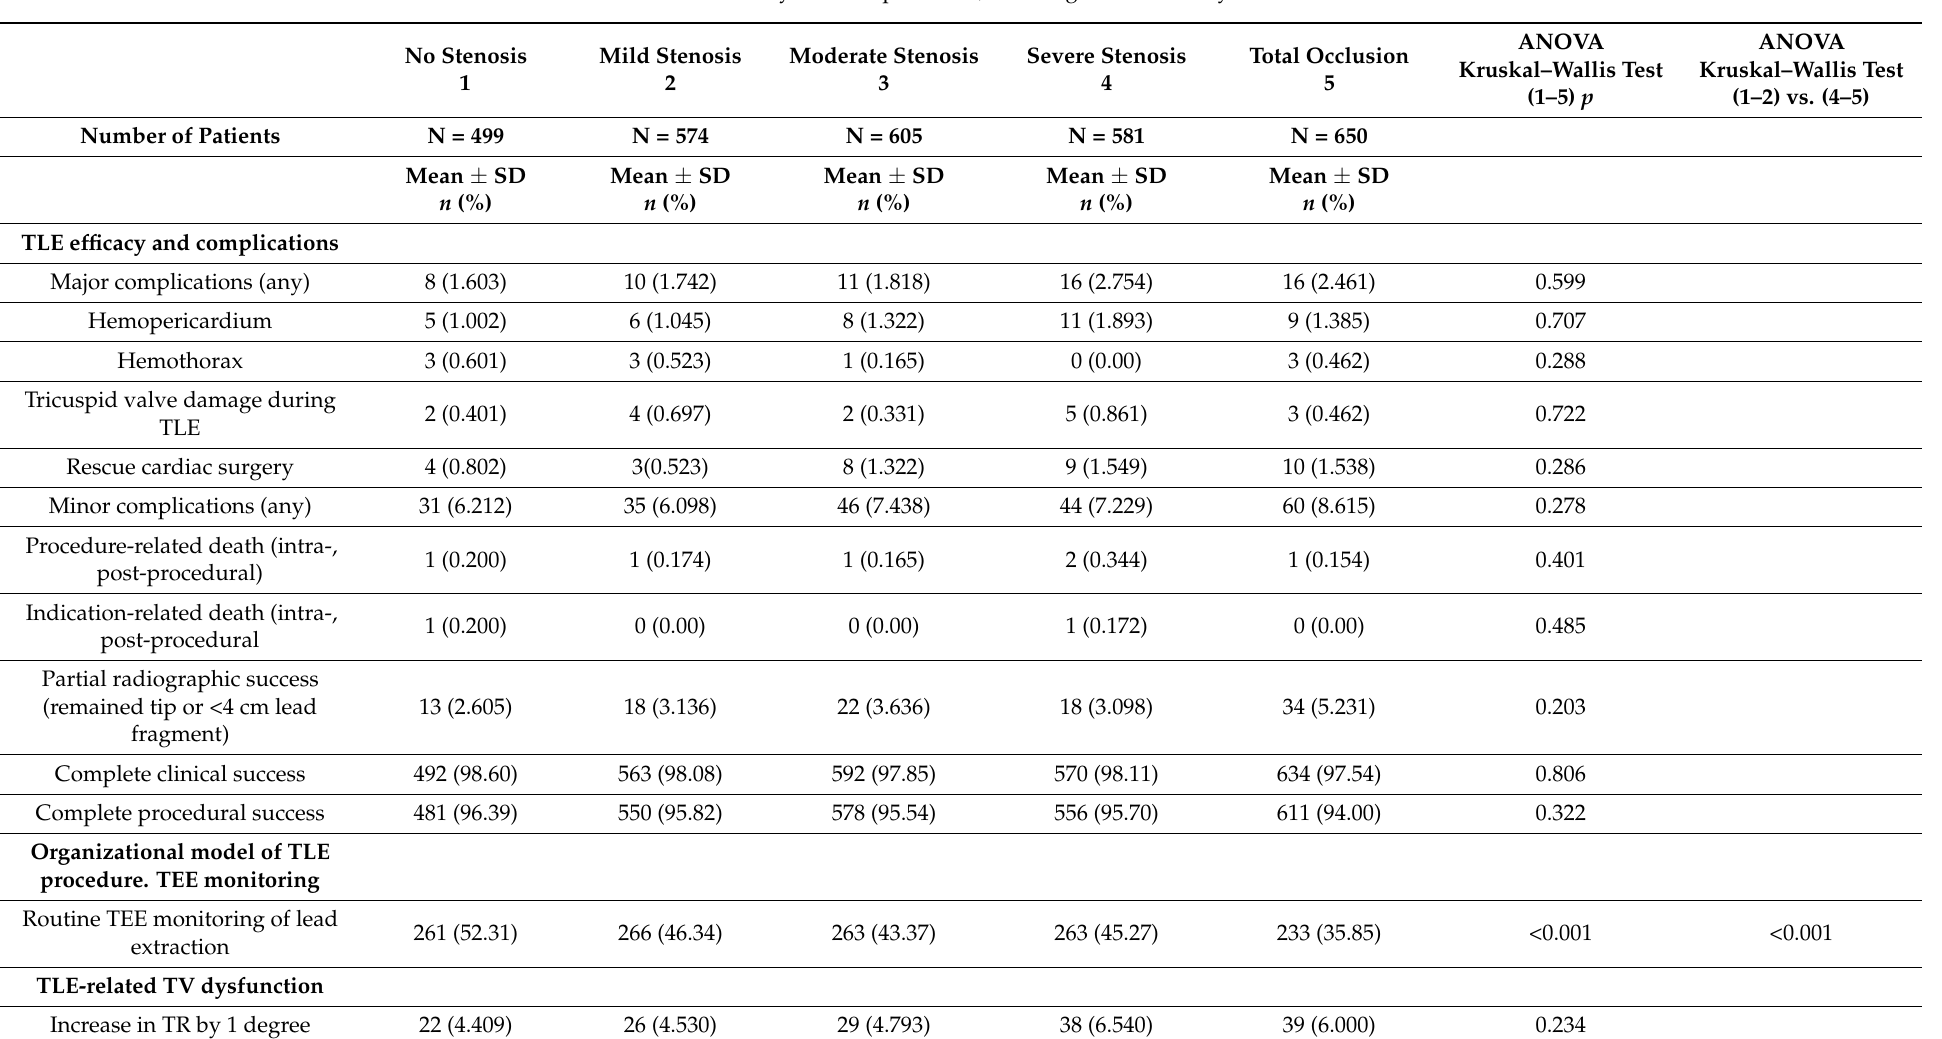
Table 4. TLE efficacy and complications, and long-term mortality after